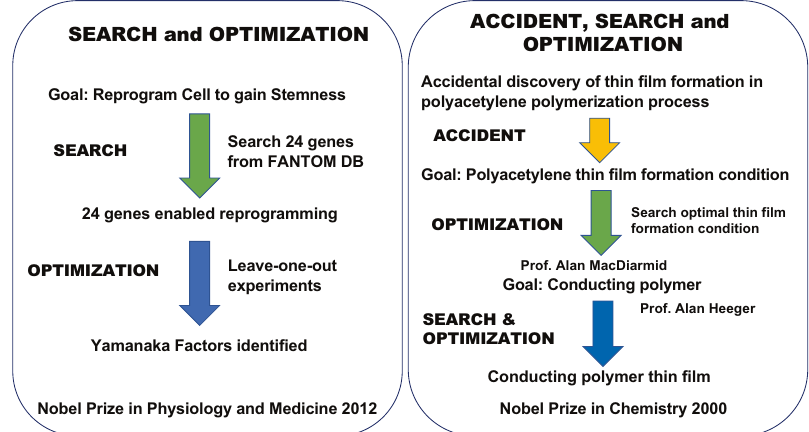
Fig. 1 Very simpli fi ed process of scienti fi c discoveries of iPS and conducting polymer. Search and optimization plays a critical role in the process of discovery. Yamanaka ’ s case is interesting because a search was conducted in bioinformatics followed by experiment-driven optimization that may be well suited for AI Scientist in the